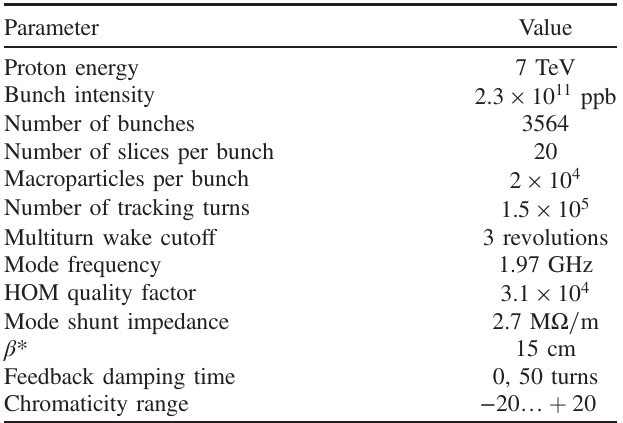
TABLE II. Parameters of the multibunch P y HEADTAIL tracking simulation used for benchmarking.